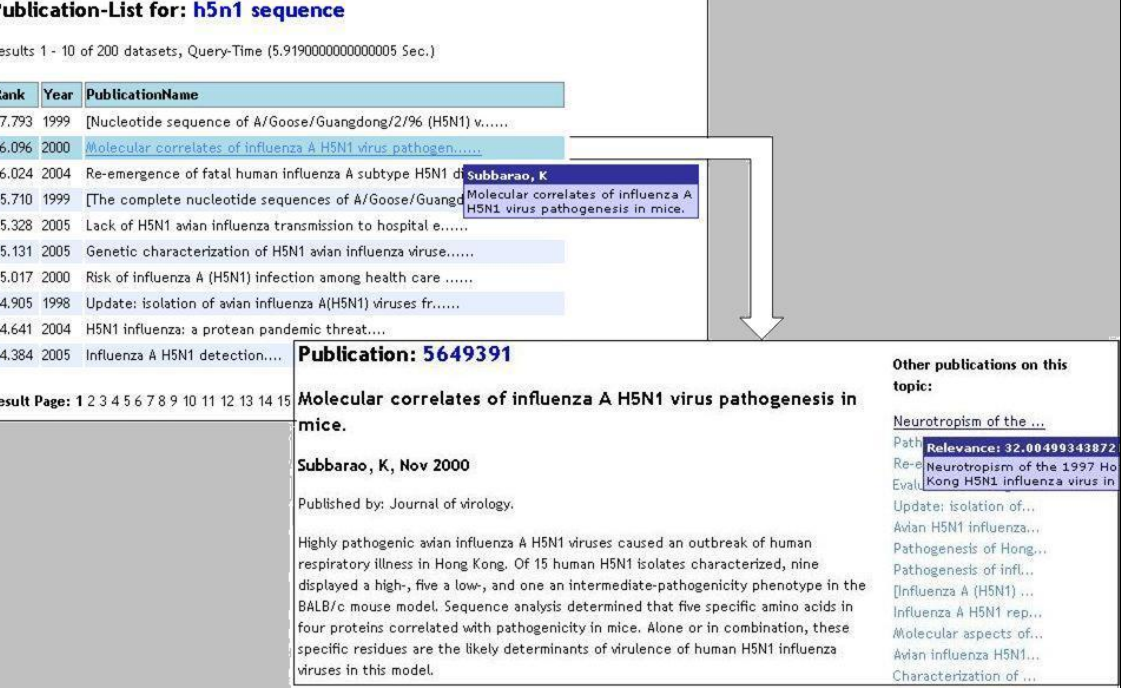
Figure 4: Here details of the MILAN-frontend are shown. On the upper left side we see a result set for the search:“h5n1 AND sequence”. The user selected the second abstract from this resultset and gets the selected paper-abstract and a relevance-list for related papers on the right side. This list is generated by a background search for all words (except if they are in the stopword-list) of the title in the current abstract. In this case the search would be: ”Molecular AND correlates AND influenza AND H5N1 AND virus AND pathogenesis AND mice”. The words “of” and “in” are in the stopword-list and have been